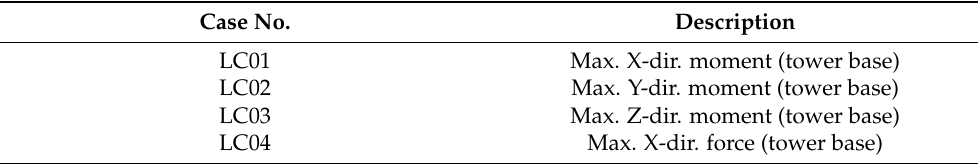
Table 9. Structural simulation